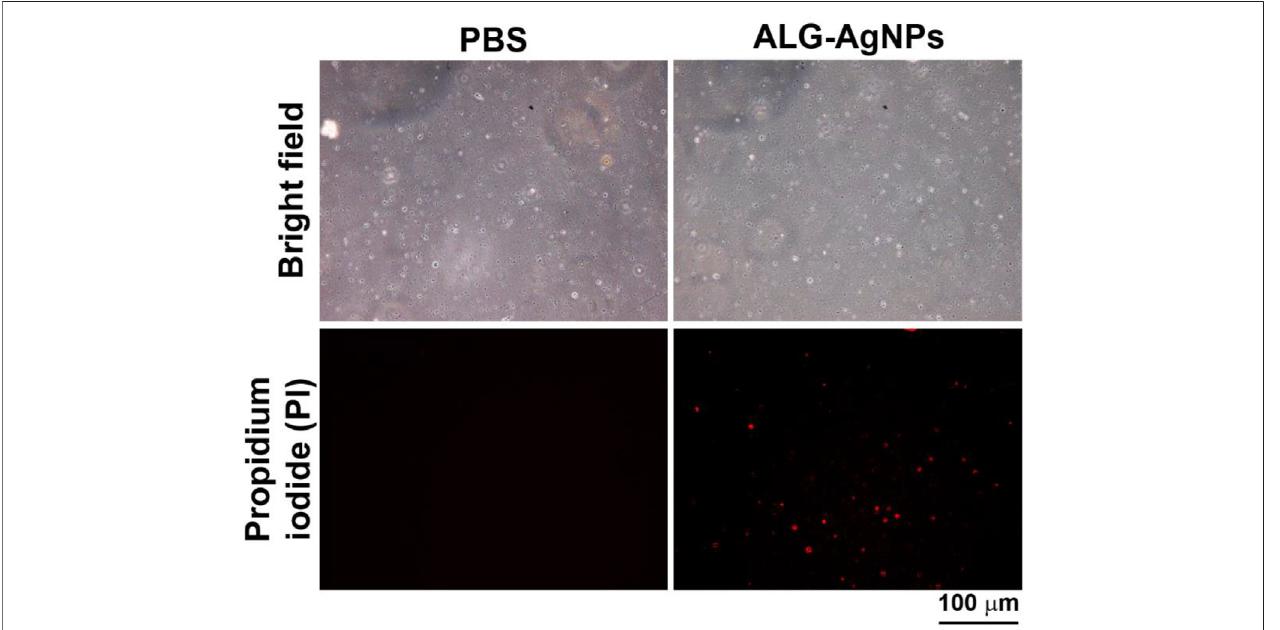
FIGURE 6 | ALG-AgNPs exert their biocidal action against Mycobacterium tuberculosis via an increase in bacterial cell-wall permeability. Log phase Mtb H37Ra cells were treated with or without 50 μ g/ml ALG-AgNPs for 24 h. Then, the bacteria were stained with propidium iodide. The images were observed at 400 × magni fi cation by fl uorescence microscopy. Scale bar represents 100 μ